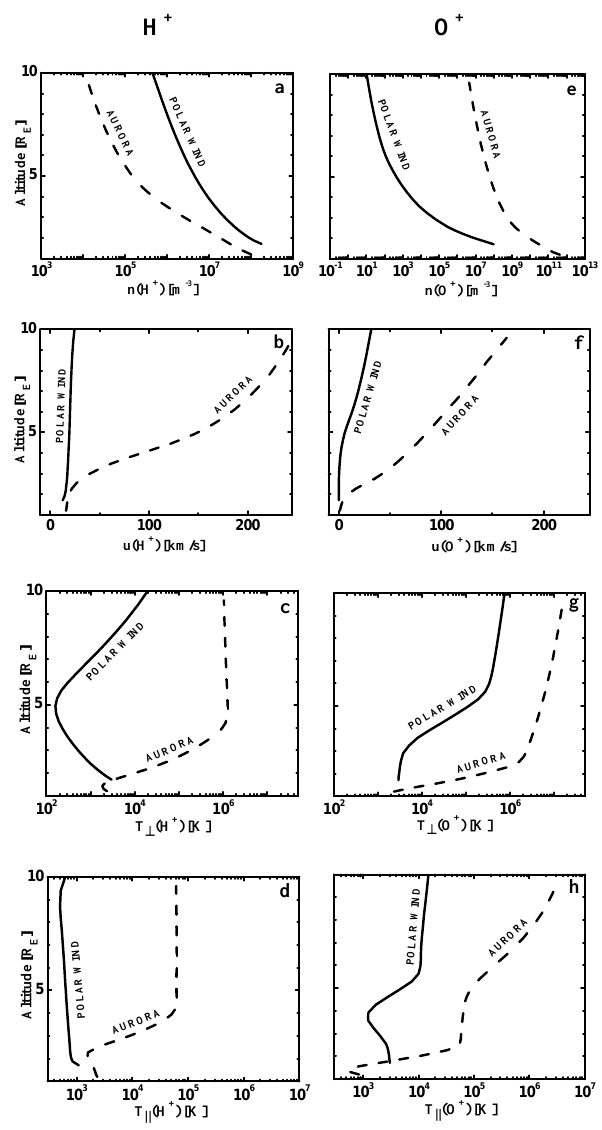
Figure 2. Altitude profiles of H + ions (left panels, a , b , c , and d ) and O + ions (right panels, e , f , g , and h ) velocity moments in the polar wind region (solid lines) and auroral region (dashed lines). The ion moments considered here are density (panels a , and e ), drift velocity (panels b , and f ), perpendicular temperature (panels c and g ) and parallel temperature (panels d and h